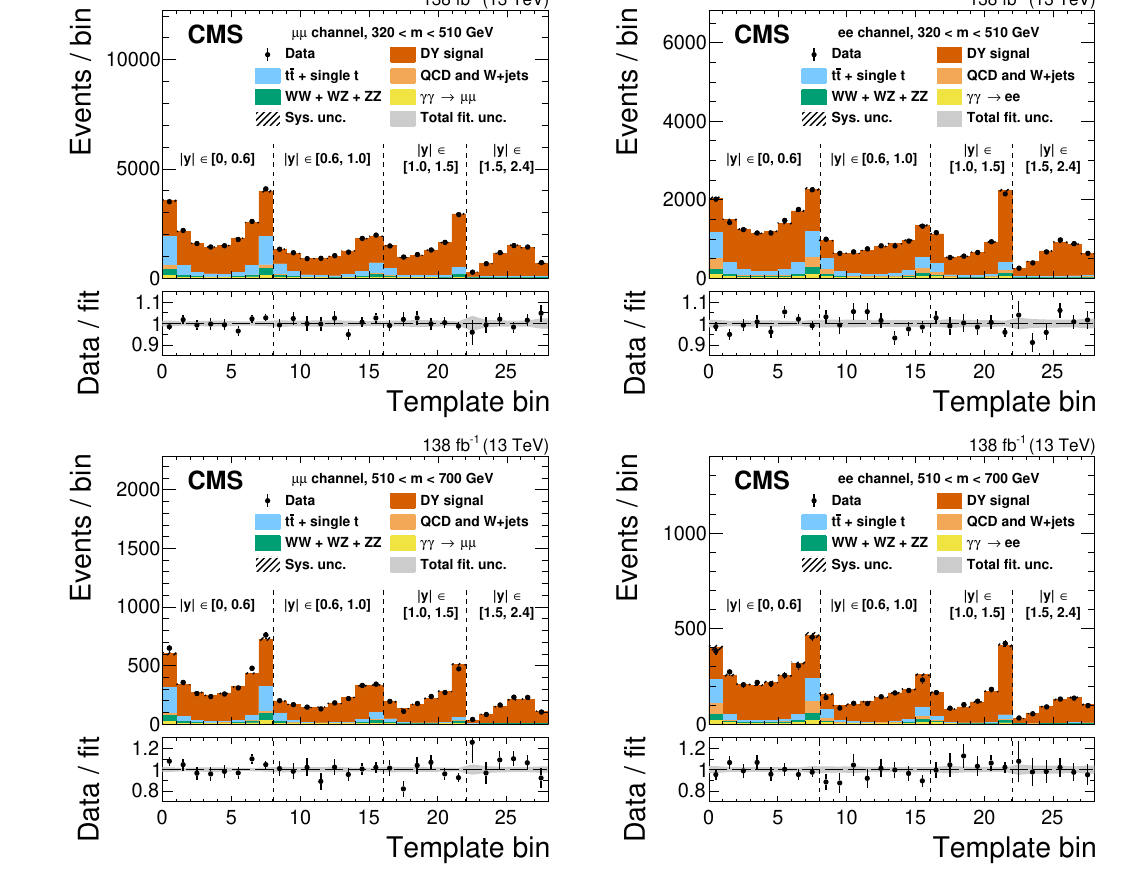
Figure 8 . The postfit distributions in the 320–510 and 510–700 GeV mass bins are shown in the upper and lower rows, respectively. The left column is the mm channel, and the right column the ee channel. The contribution of the tt background is not visible on the scale of these plots and has been omitted. The 2D templates follow the cos θ and | y | binning defined in section 7 but are R presented here in one dimension, with the dotted lines indicating the different | y | bins. The black points and error bars represent the data and their statistical uncertainties. The bottom panel in each figure shows the ratio between the number of events observed in data and the best fit value. The gray shaded region in the bottom panel shows the total uncertainty in the best fit